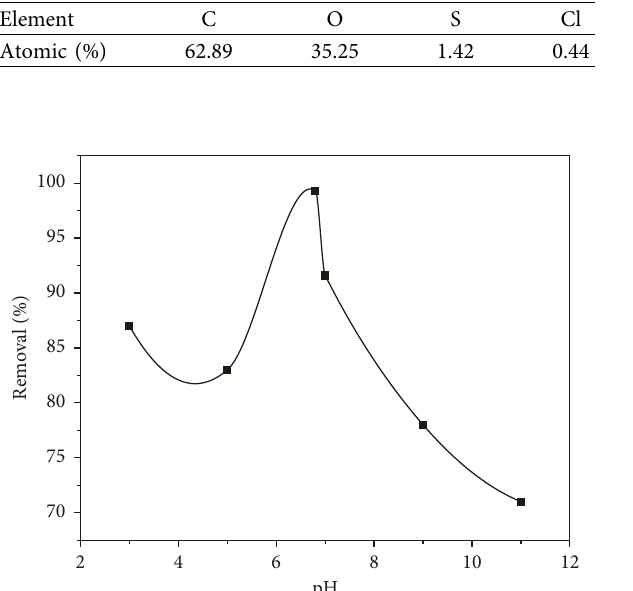
Figure 6: Effect of pH on the removal of F − obtained from the NaF solution.